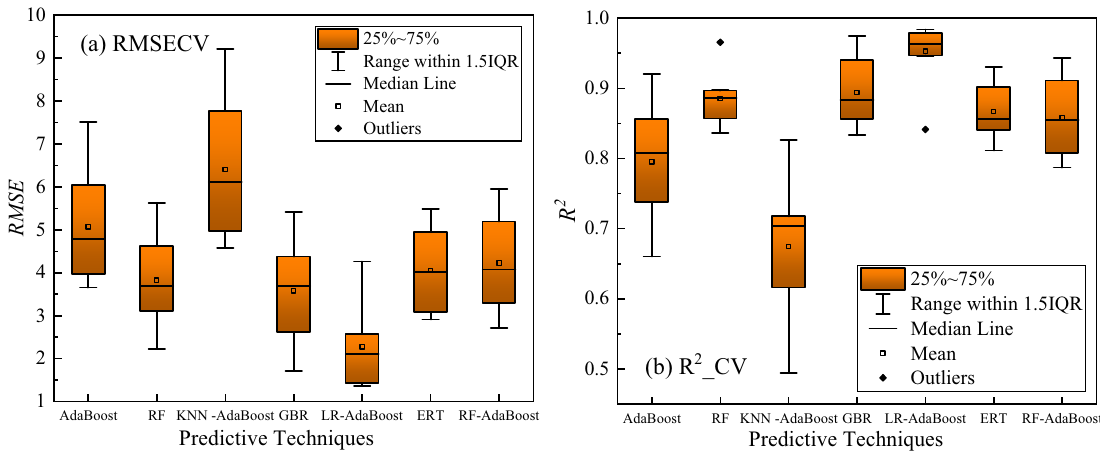
Figure 6: Box plots of ( a ) RMSECV and ( b ) R 2 _CV for seven ensemble methods.